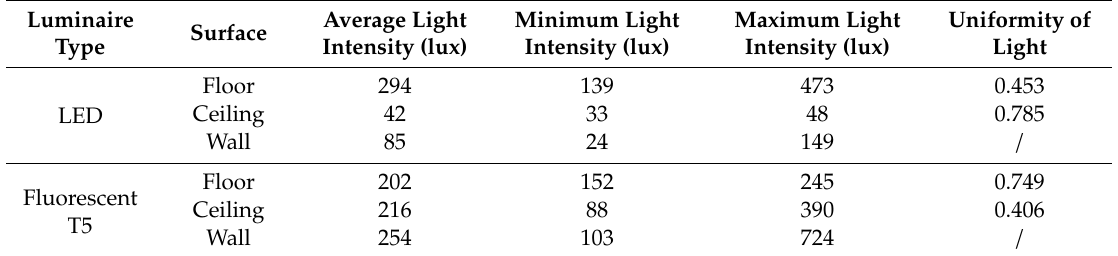
Table 3. The lighting characteristic from simulation on experimental